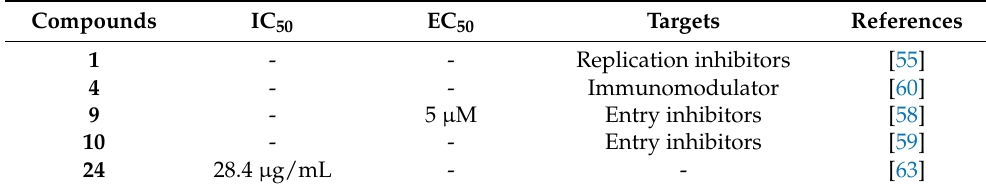
Table 2. Summary of anti-influenza-virus triterpenoids and their targets and